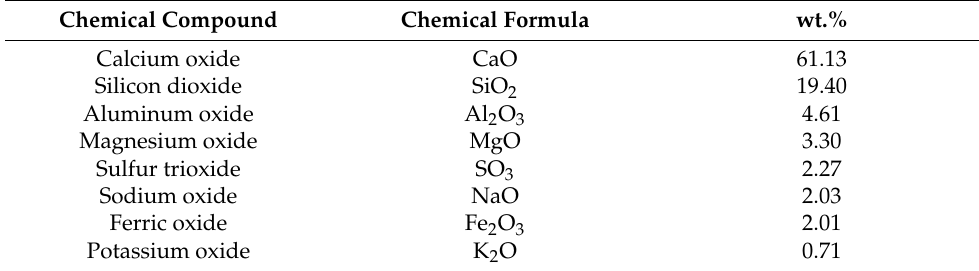
Table 2. Chemical composition of general use